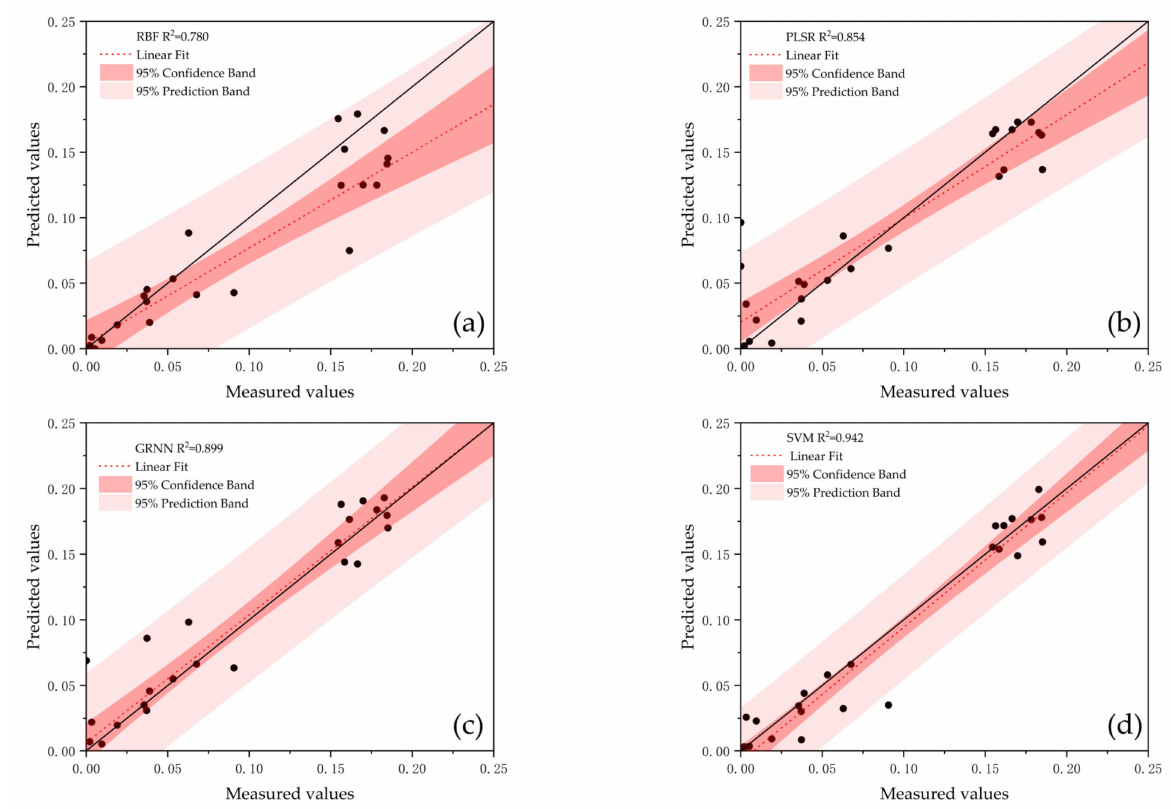
Figure 8. Model prediction of first-order derivative spectral data ( a ) RBF, ( b ) PLSR, ( c ) GRNN, ( d ) SVM. The measured values and predicted values are expressed as the copper grade of the test samples and the predicted value of the model. The black line shows the 1:1 relationship and the dashed line shows the model trend. In the data augmentation domain, the input spectra with ranges of 450–1700 nm for copper grade were selected to develop multivariate regression models. The SVM model falls within the largest number of points within the 95% confidence